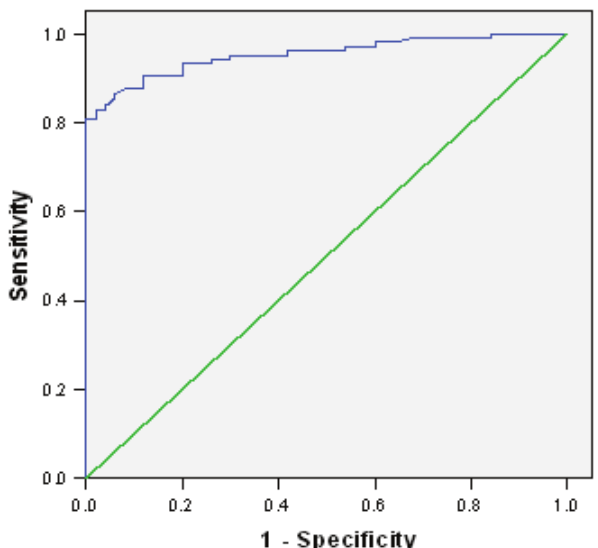
Figure 6 : ROC analysis of optimal cut-off value for serum ADA level to differentiate cases of tubercular lymphadenitis from reactive lymphadenitis (Department of Pathology, TMU from January 2019 to June 2020) n = 104.